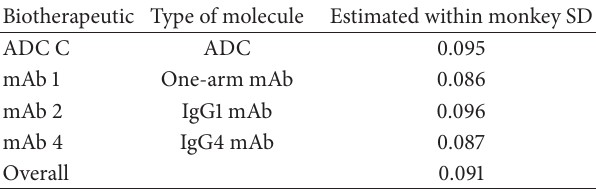
Table 2: Estimation of within monkey variability across biothera- peutics. Four types of biotherapeutics were spiked in two baseline samples taken 1 week apart from 15 cynomolgus monkeys and tested in the assay. The background data from the biotherapeutic spiked samples showed that within monkey signal variability was similar. Therefore, the overall variability obtained with these four molecules could be used to estimate a generic cut point